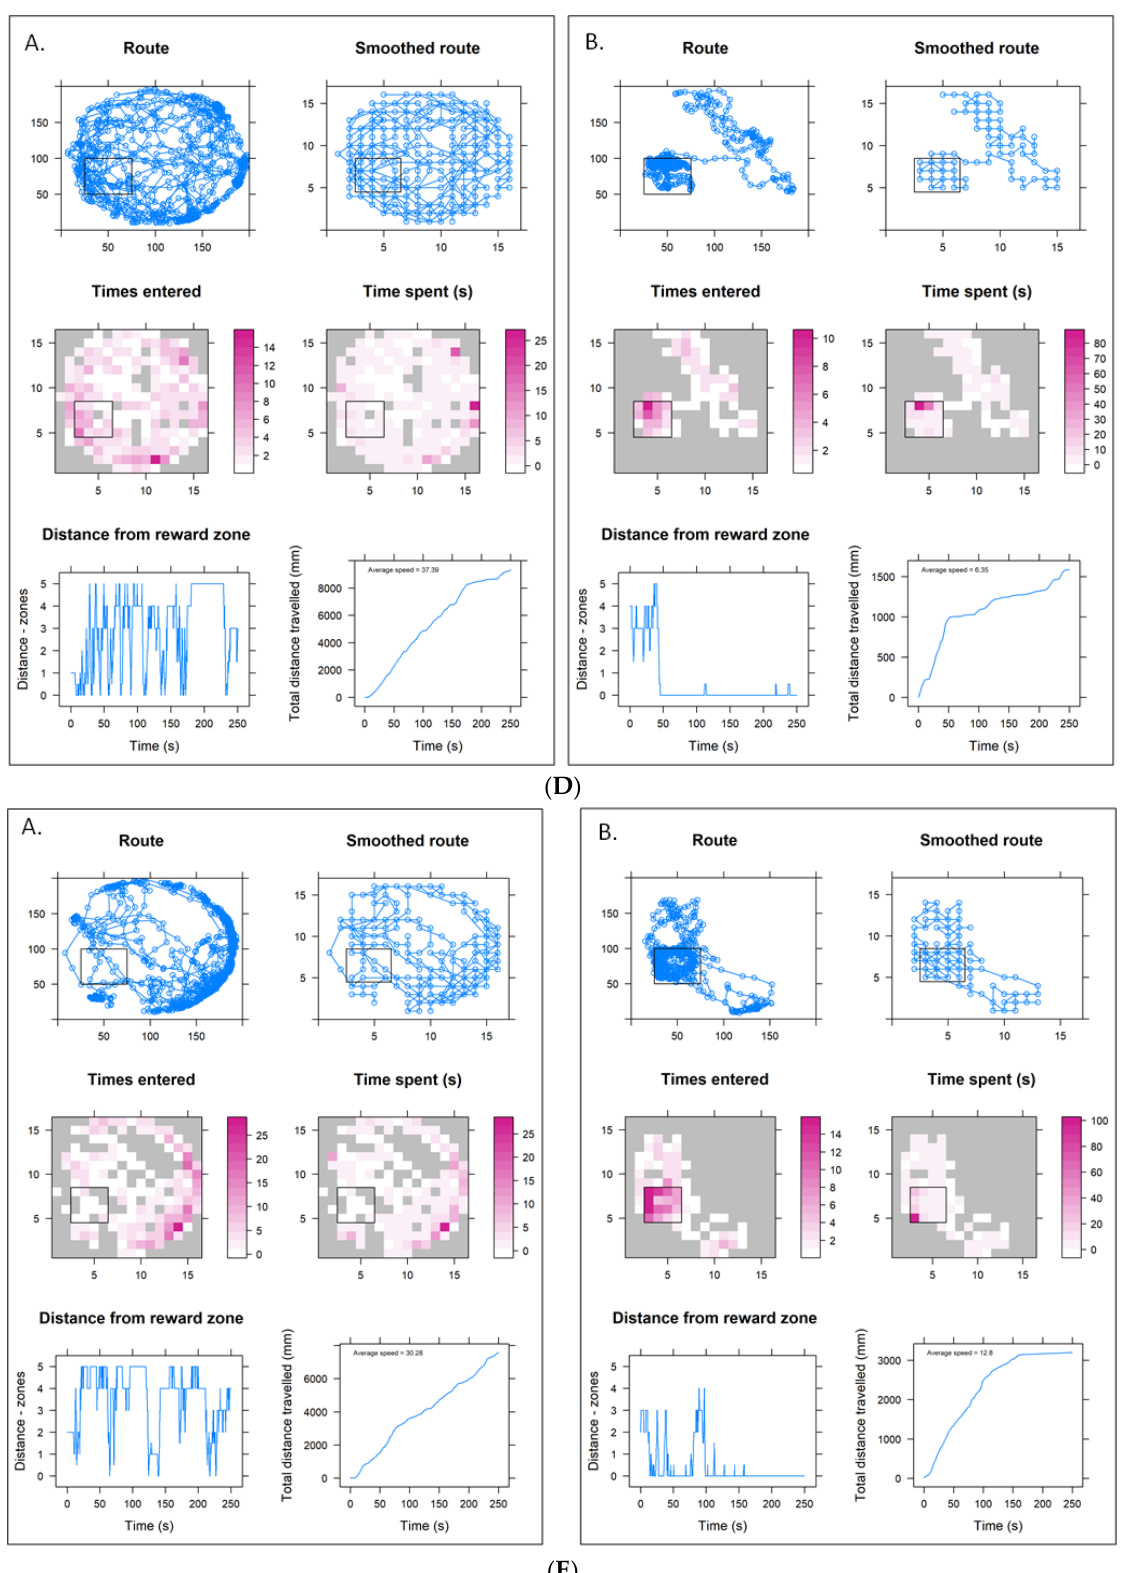
Figure 3. ( A ) Training parameters from a control bee (B63) pre- (panel A) and post- (panel B) training. Control condition identical between lower and higher concentration trials. In each case the black square outline indicates the cool tile reward zone location within the arena. ( B ) Training parameters from a lower concentration sulfoxa fl or bee (B37) pre- (panel A) and post- (panel B) training. ( C ) Training parameters from a lower concentration thiacloprid bee (B56) pre- (panel A) and post-